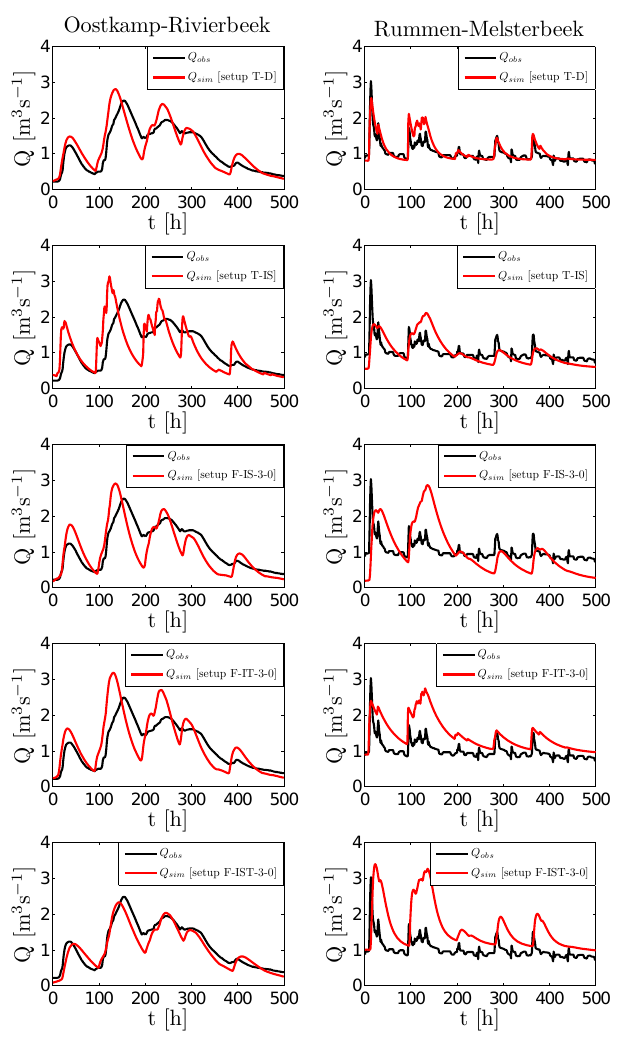
Fig. 11. Comparison of the observed and simulated time series for calibration set-ups T-D (1), T-IS (2), F-IS-3-0 (3), F-IT-3-0 (4) and F-IST-3-0 (5) in catchments Oostkamp–Rivierbeek and Rummen– Melsterbeek. A part of the validation period is